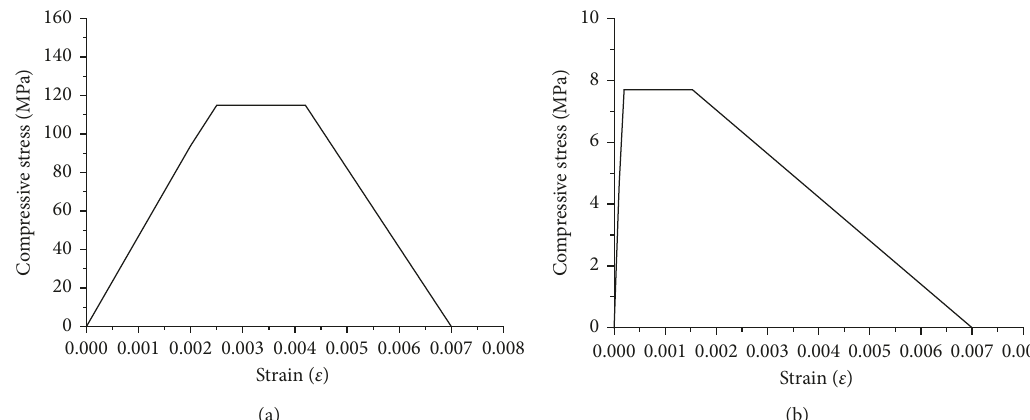
Figure 13: Stress-strain curve of UHPFRC under (a) uniaxial compression and (b) uniaxial tension.